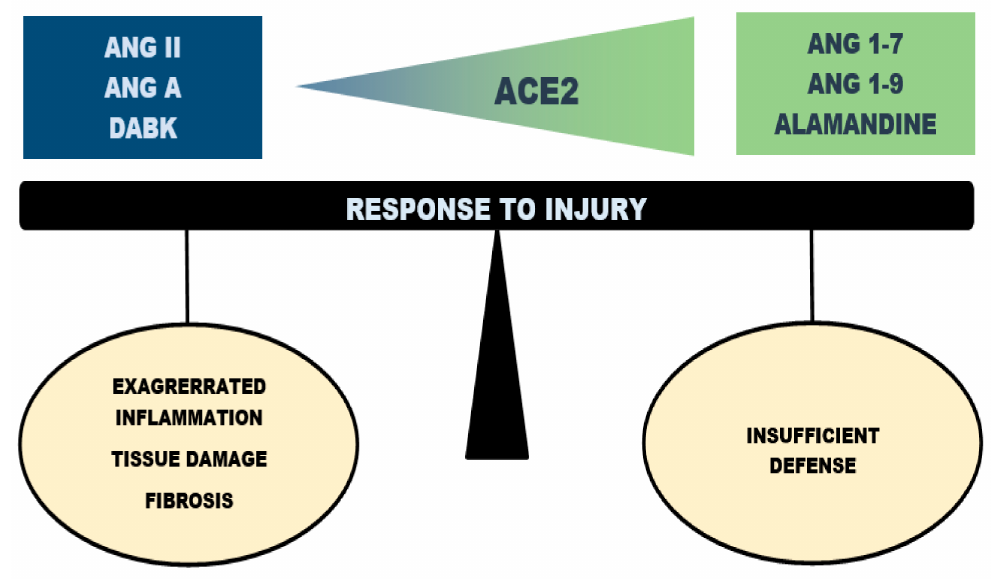
Figure 3. Regulatory role of angiotensin-converting enzyme 2 in the pathogenesis of acute lung injury and ARDS. Increasing / decreasing activity of the angiotensin-converting enzyme 2 (ACE2) regulates the dynamic balance within the RAS. Ang II—angiotensin II; Ang A—angiotensin A; DABK—des-Arg 9 -bradykinin; Ang 1–7—angiotensin 1–7; Ang 1–9—angiotensin